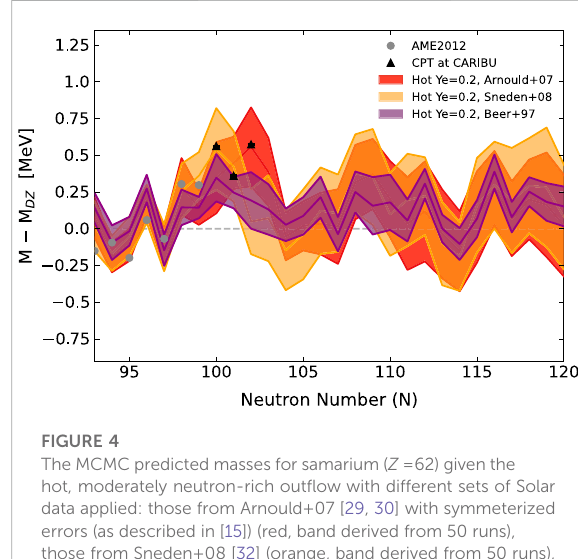
The MCMC predicted masses for samarium ( Z =62) given the hot, moderately neutron-rich out fl ow with different sets of Solar data applied: those from Arnould+07 [29, 30] with symmeterized errors (as described in [15]) (red, band derived from 50 runs), those from Sneden+08 [32] (orange, band derived from 50 runs), and those reported in Beer+97 [31] (purple, band derived from 25